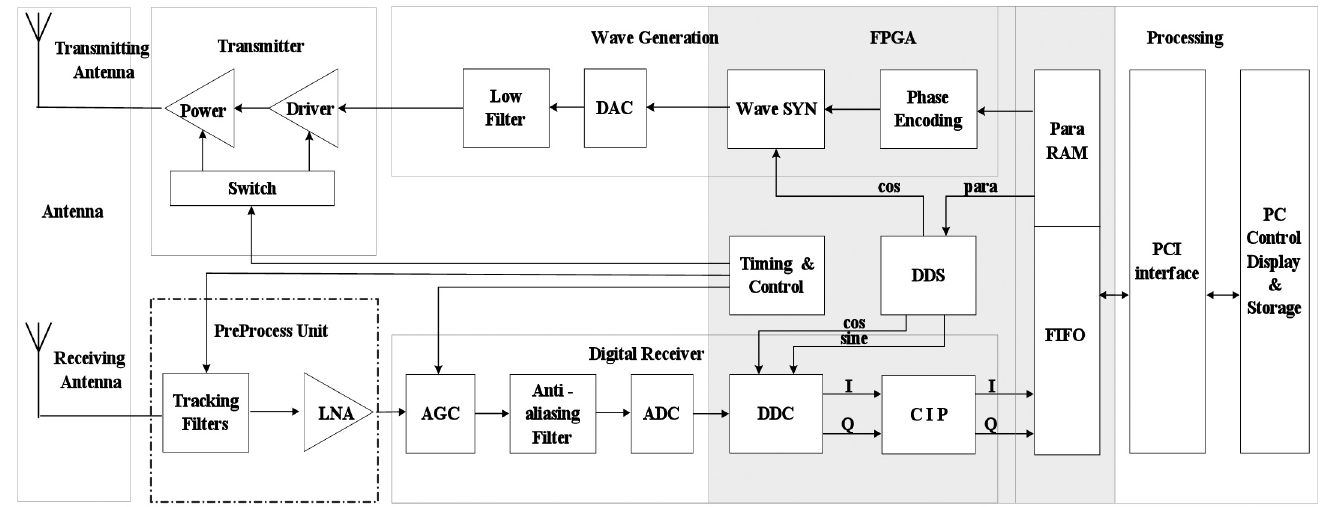
Figure 1. Block diagram of the CAS-DIS.